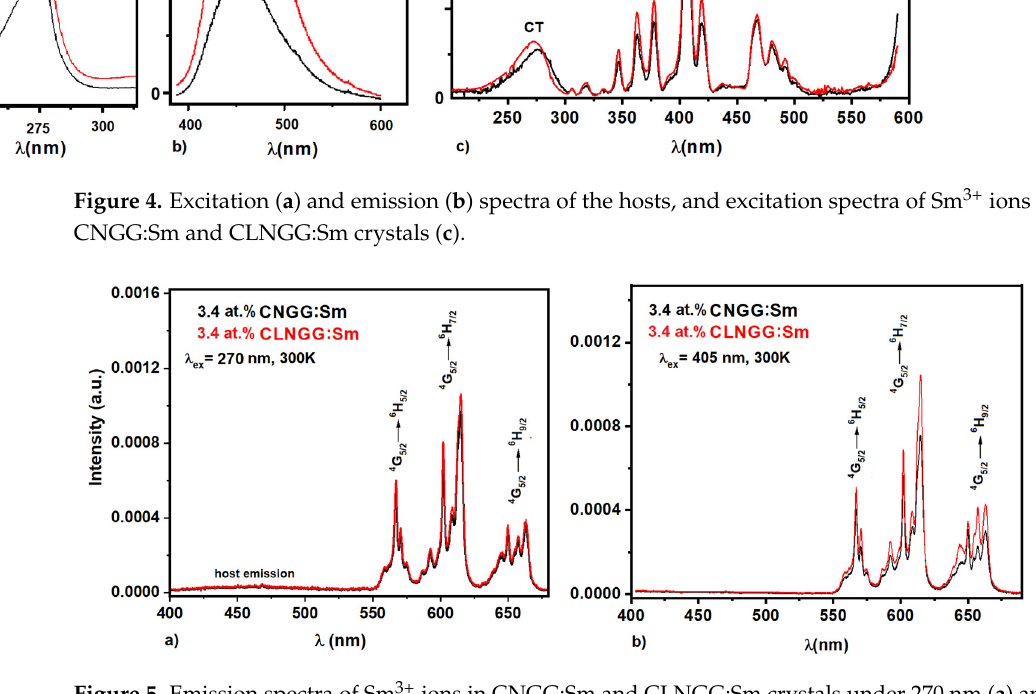
Figure 5. Emission spectra of Sm 3+ ions in CNGG:Sm and CLNGG:Sm crystals under 270 nm ( a ) and 405 nm ( b ) excitation wavelengths. Table 4. Emission cross-sections of Sm 3+ ions in CNGG:Sm and CLNGG:Sm crystals compared to other similar crystals. (Reprinted with permission from Ref. [21], copyright 2017, Elsevier).